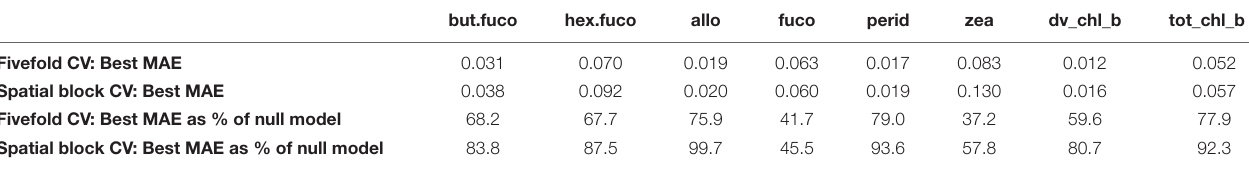
TABLE 4 | Comparison of the best algorithms’ mean absolute errors (MAEs) calculated with fivefold cross-validation and with spatial block cross-validation. but.fuco hex.fuco